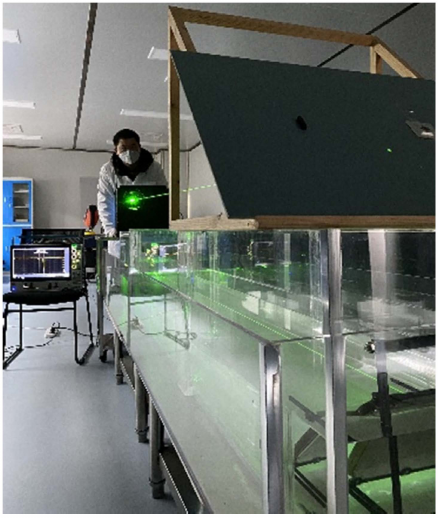
Figure 20. The overall physical diagram of the laboratory validation.